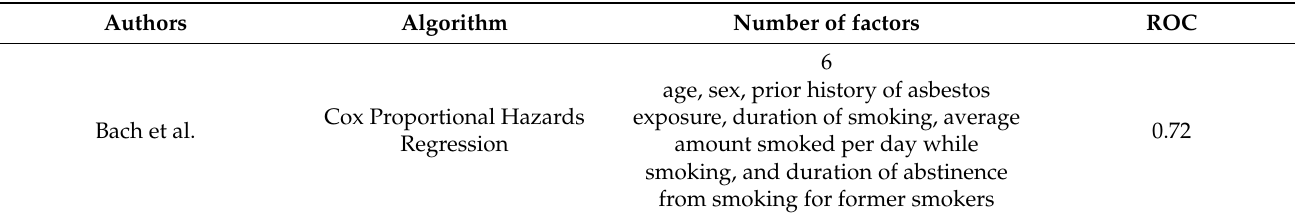
Table 1. Related work